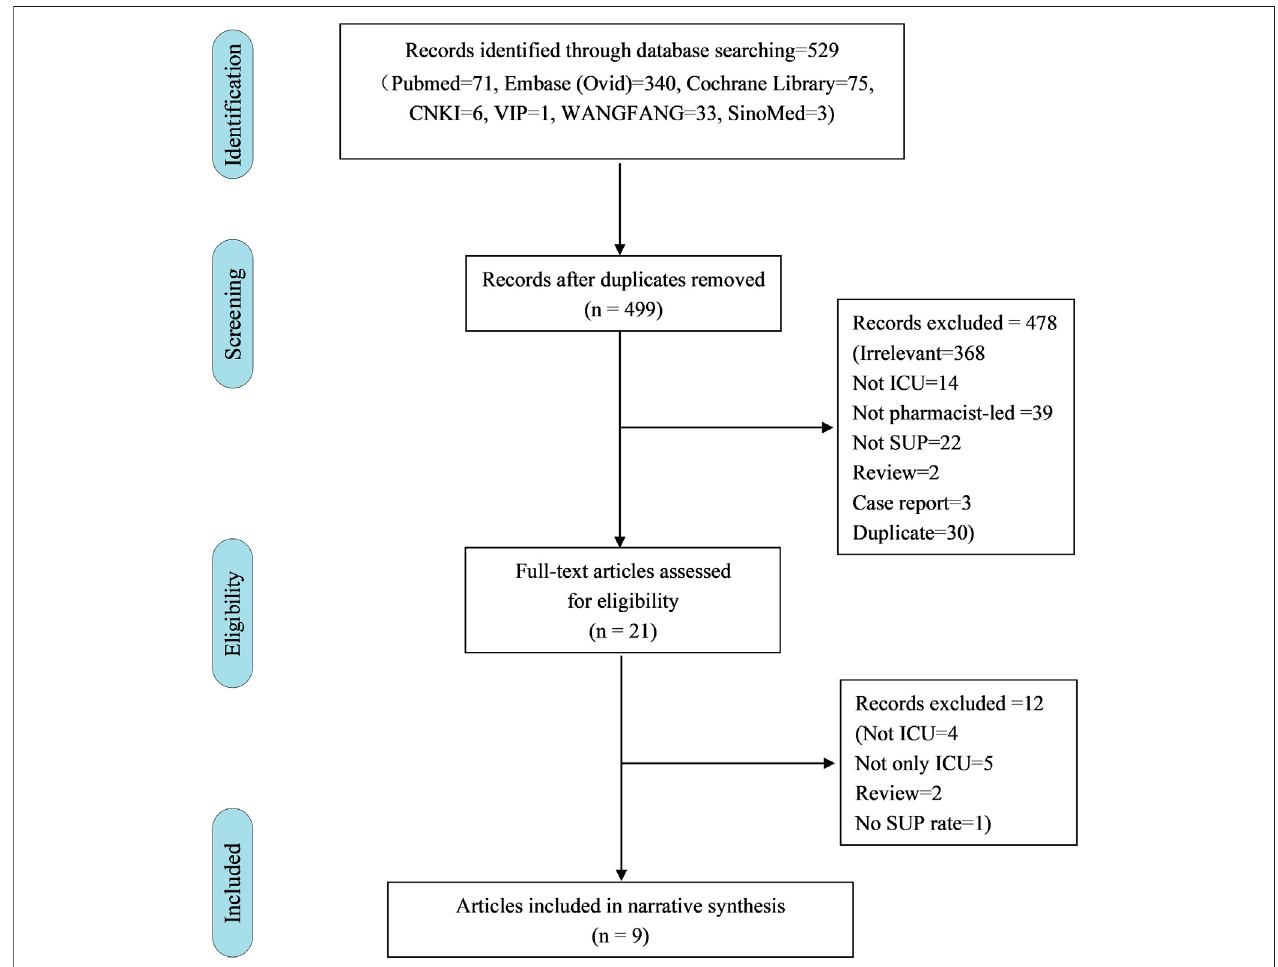
FIGURE 1 | Flow chart for screened